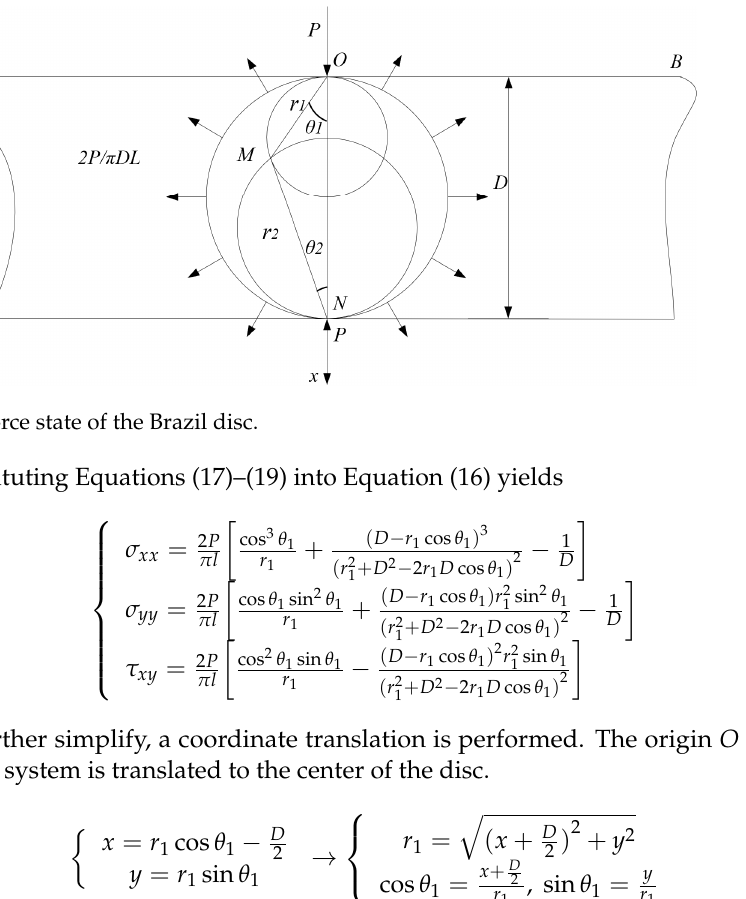
Figure 7. Force analysis of the disc. ( a ) Half plane of infinite plate on the role of P in the level of vertical load on the boundary AB. ( b ) The plates on both sides are infinitely long, the width is D , and the thickness of the plate is l , which is affected by a pair of symmetrical line load P .